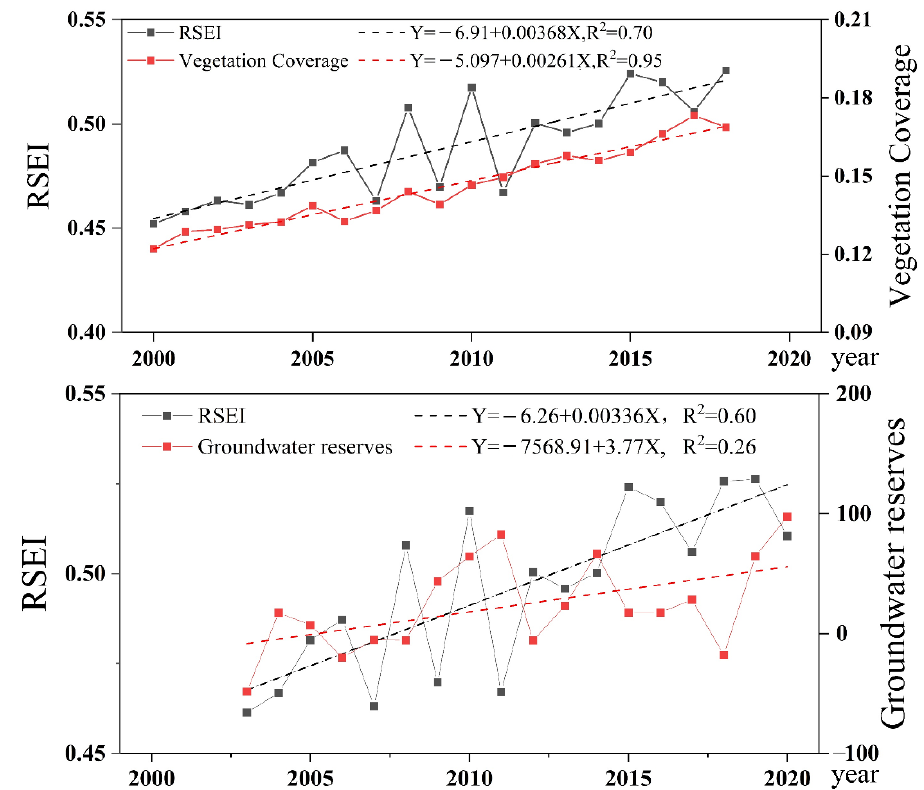
Figure 10. RSEI and groundwater storage, coverage mean change statistics.